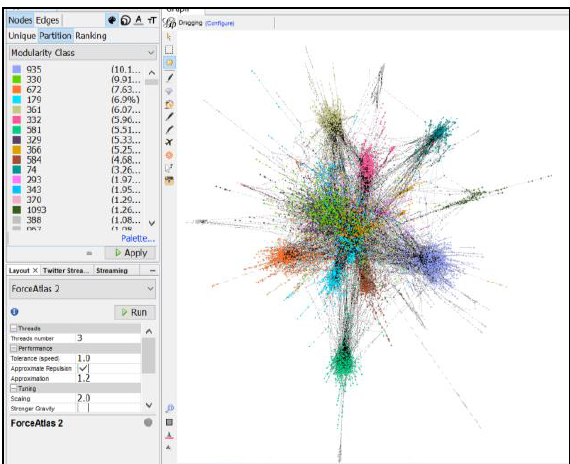
Figure 5. Coloring the communities with modularity